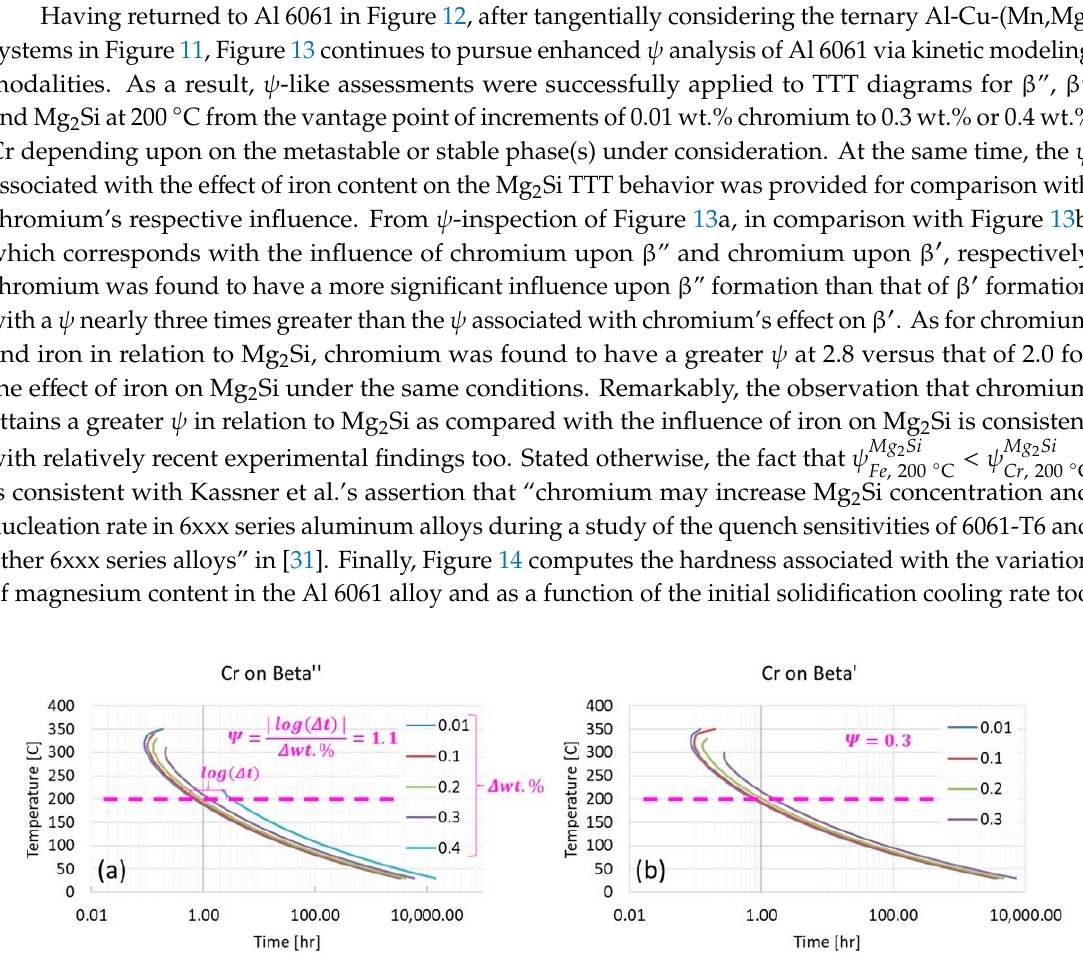
Figure 14. The hardness associated with the variation of magnesium content in the Al 6061 alloy, as a function of the initial solidification cooling rate, as presented herein, upon solidifying from a temperature of 700 °C. In addition to calculating the EIF for equilibrium phases, EIFs can also be calculated for metastable phases. Currently, due to the limitations of the kinetic and thermodynamic software utilized, the only way to calculate phase fraction diagrams for metastable phases requires the suspension of phases suspected or known to be absent at desired conditions. An example of the phase 20 25